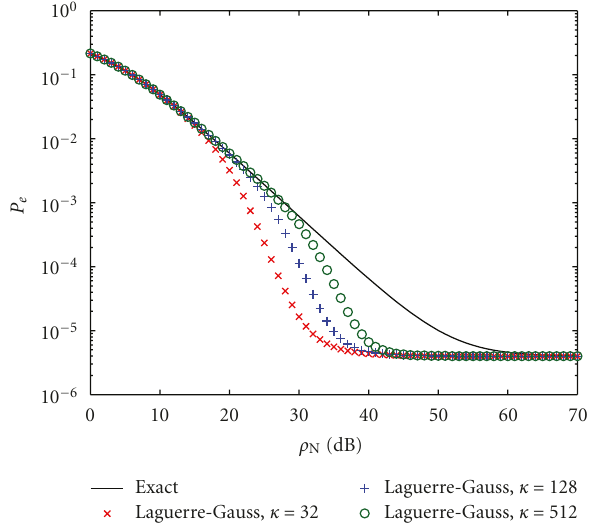
Figure 5: Approximation by Laguerre-Gauss quadrature ( ρ I = 13 dB).